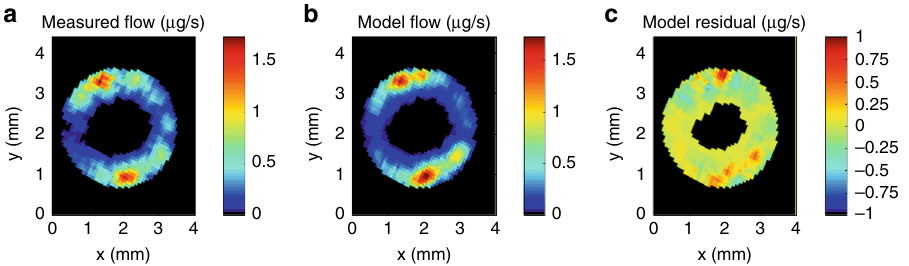
Fig. 4 Masked scenario. a Observed fl ow rates ( µ g s − 1 , colour scale) averaged in 5-by-5 pixel window, cropped to the inner xylem domain (see Fig. 2c) only. b Model predicted fl ow rates ( µ g s − 1 , colour scale) with single pressure set at top of domain, optimized over inner domain only, downsampled to 78 µ m resolution and averaged over 5-by-5 pixel window. ( c ) Residuals between model and observed ( µ g s − 1 , colour scale).